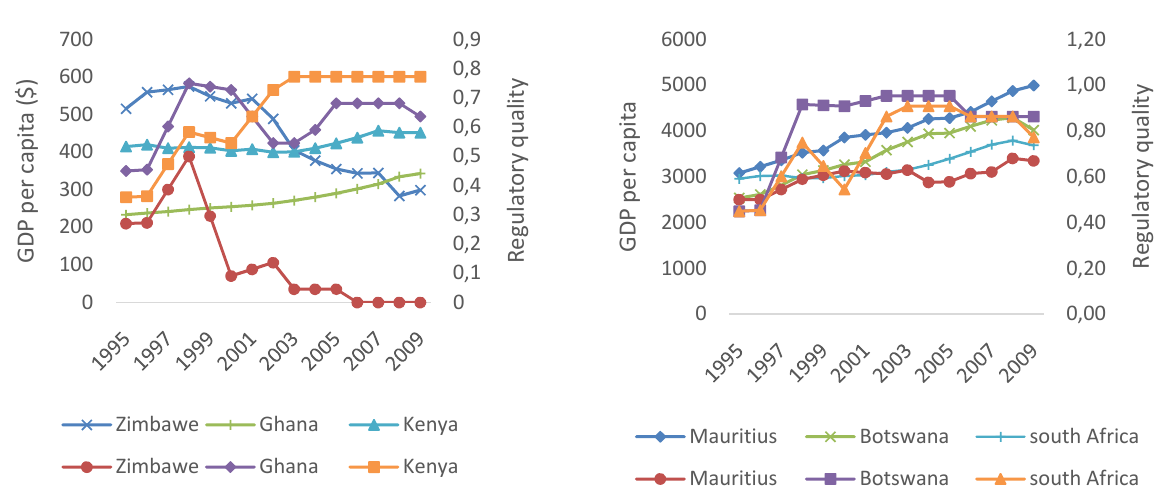
Fig. 2. GDP per capita and regulatory